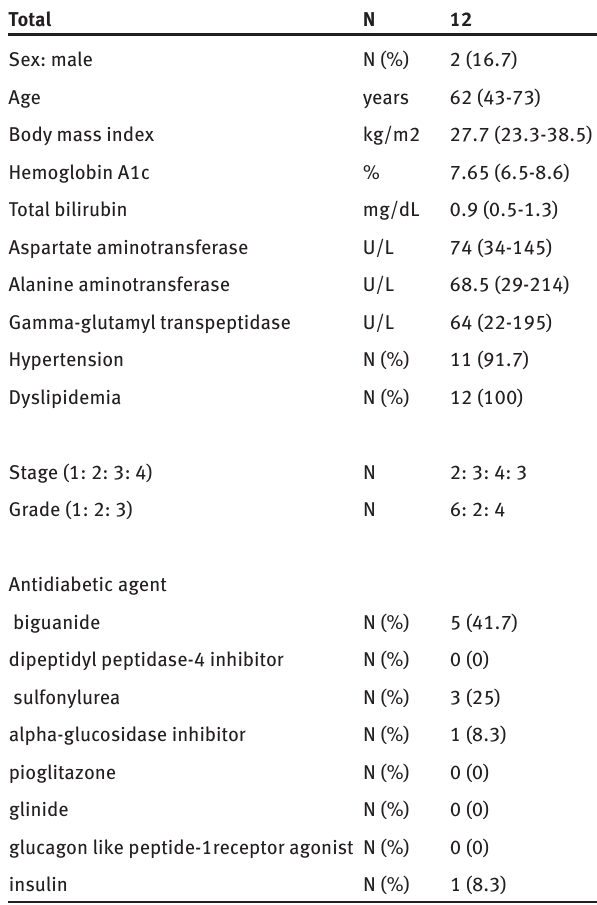
Table 1: Baseline characteristics of 12 patients with non-alcoholic